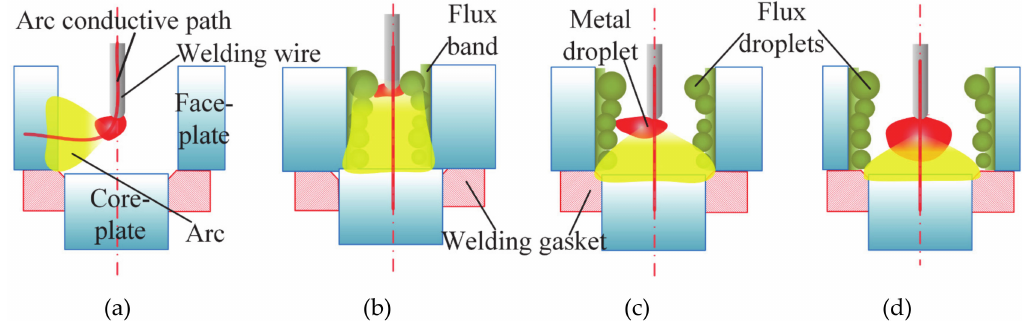
Figure 9. The arc behavior and droplet transfer modes in ( a ) GMAW and FBCA welding process under di ff erent groove gaps: ( b ) 3 mm (strong constricting e ff ect) ( c ) 6 mm (medium constricting e ff ect) ( d ) 10 mm (weak constricting e ff